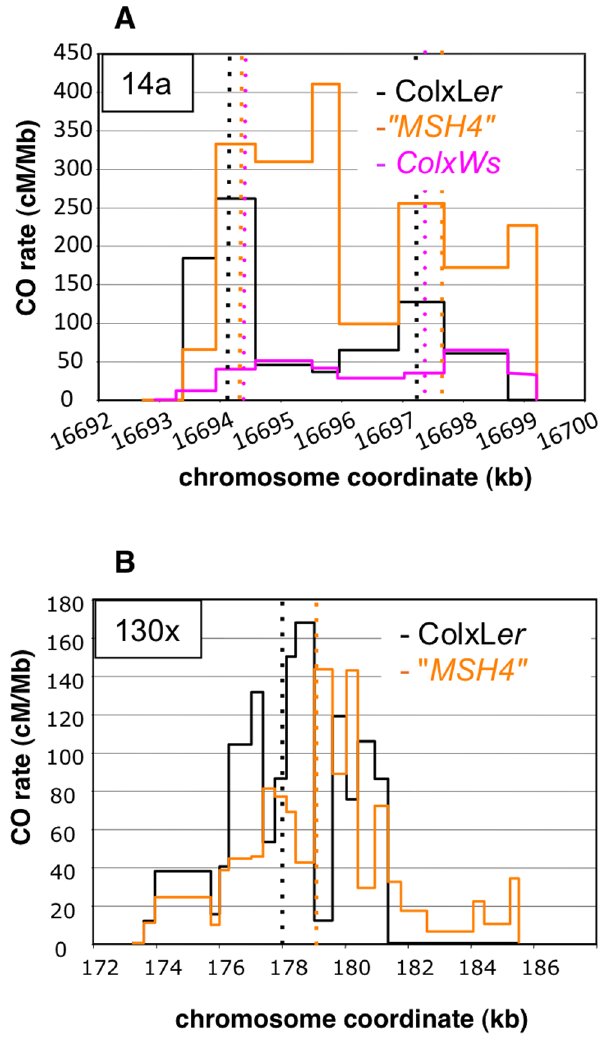
Figure 8. Distribution of CO rates across the 14a (A) and 130 6 (B) hotspots in different genetic backgrounds. (A). One hundred and four, 108 and 87 COs were analyzed in ColxL er (black), ‘‘ MSH4 ’’ (orange) and ColxWs (purple), respectively. Thin dotted vertical lines: median position at 14a1 and 14a2 for each distribution. (B). One hundred and sixty seven and 245 COs were analyzed in ColxL er and ‘‘ MSH4 ’’, respectively. Thin dotted vertical lines: median position for each distribution. Using a Fisher exact test, the two distributions were found to be highly significantly different ( p-value =2.2 6 10 2 16 ).